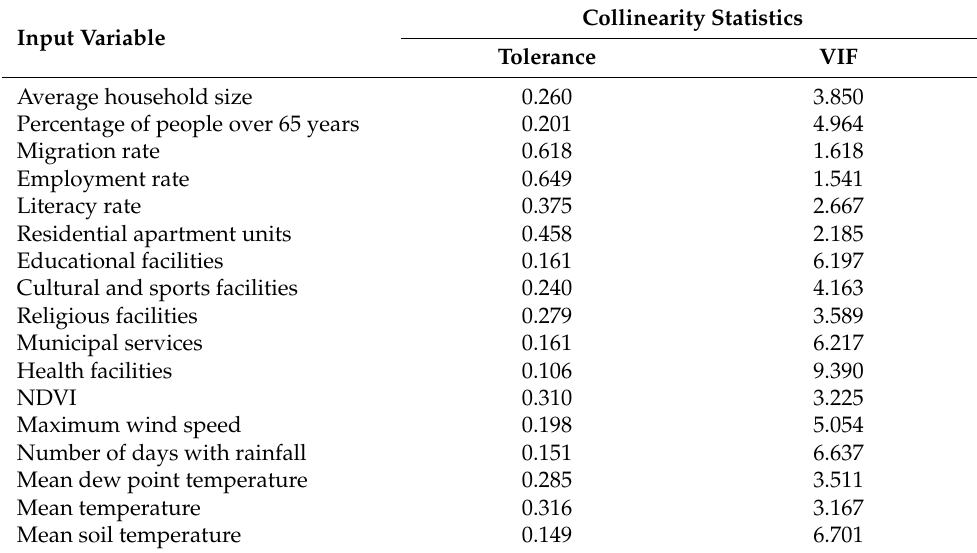
Table 3. Multicollinearity analysis of input variables in the LR model.